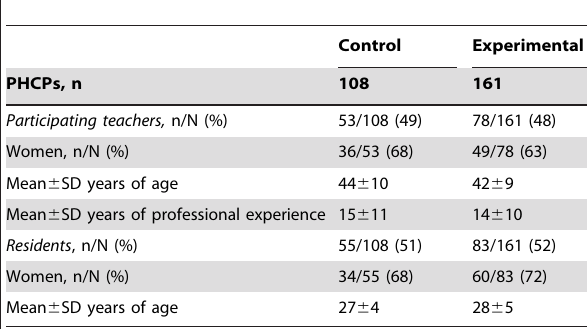
Table 1. Characteristics of participants.